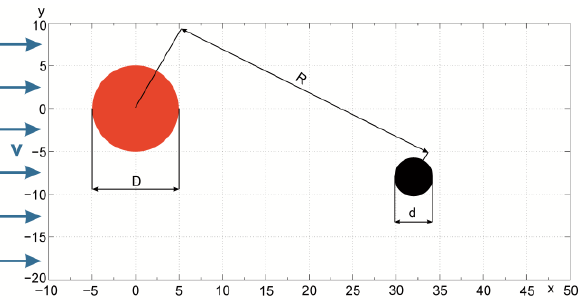
Figure 2. The set-up of the cylinders and coordinate system (cid:11) (cid:20)(cid:5)(cid:18)(cid:14)(cid:15)(cid:4)(cid:18) (cid:11)(cid:11)